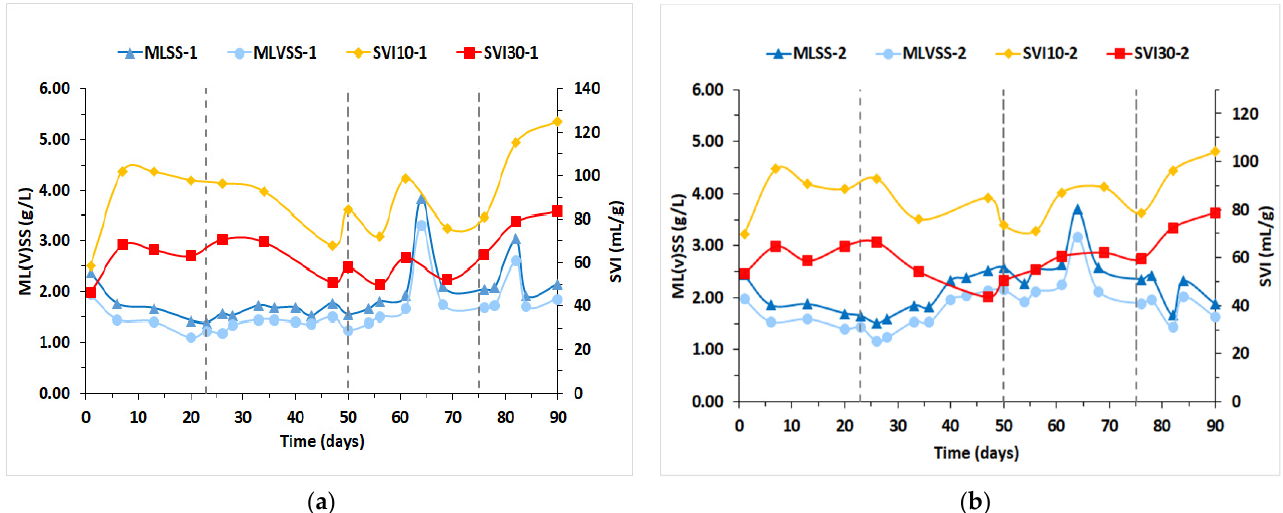
Figure 2. Evolution of the sludge parameters during the operational period in the anaerobic reactor (MLSS-1, MLVSS-1, SVI 10 -1, and SVI 30 -1) ( a ); and the aerobic reactor (MLSS-2, MLVSS-2, SVI 10 -2, and SVI 30 -2) ( b ).